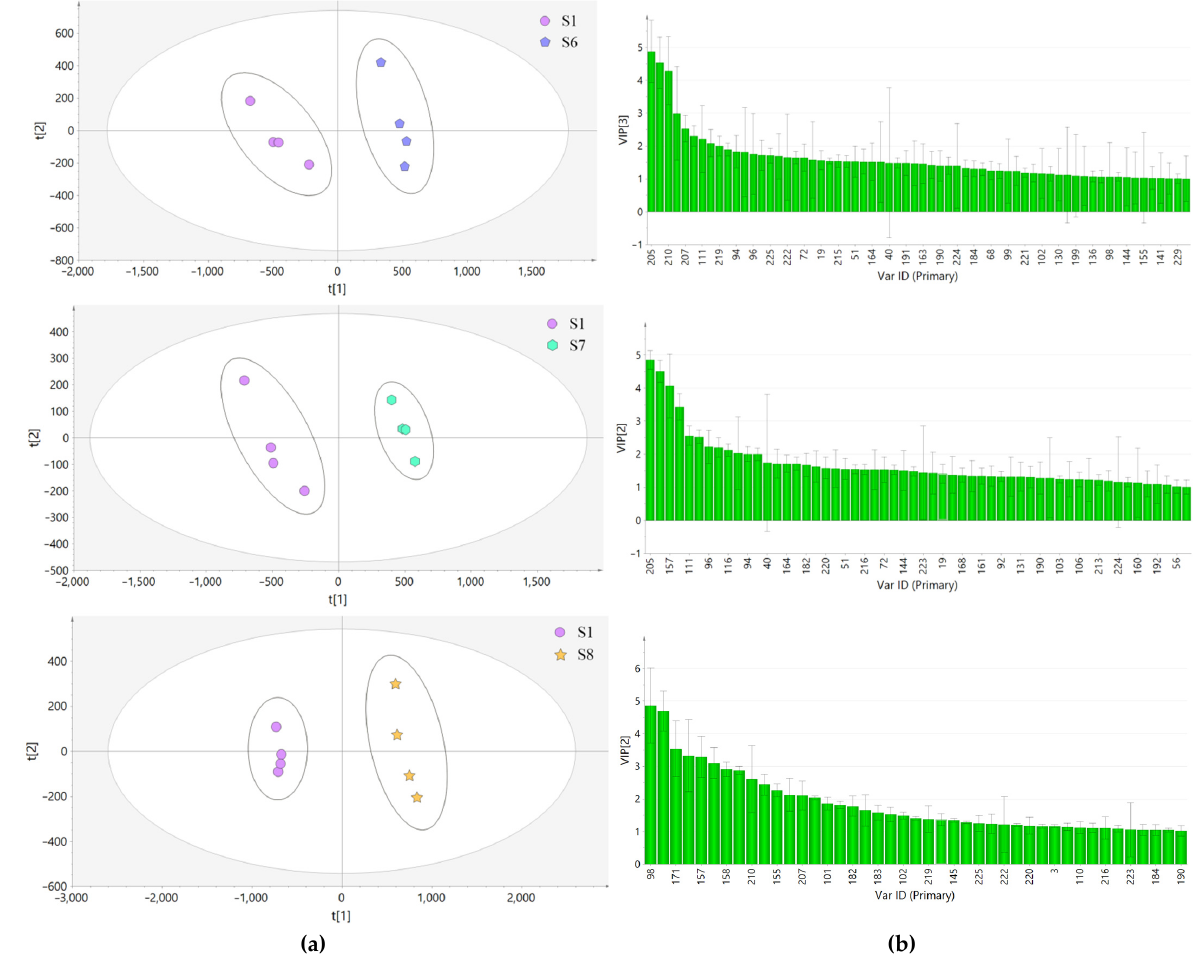
Figure 10. PLS-DA score plot ( a ) and VIP score plot ( b ) of LH samples from different habitats. Table 2. PLS-DA results of LH samples from different habitats in Sichuan Basin.